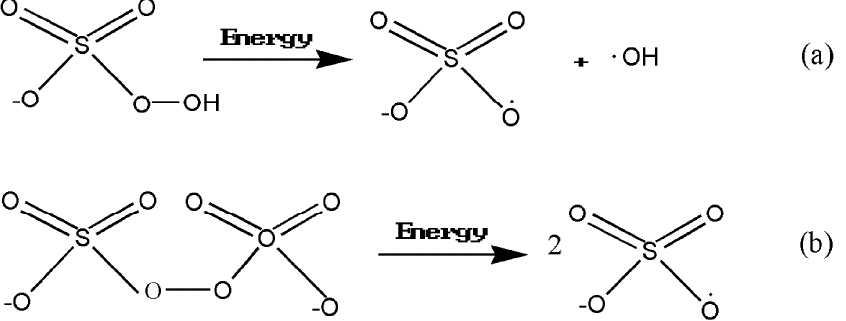
Figure 1. The activation reactions of PMS ( a ) and PS ( b ) by energy.